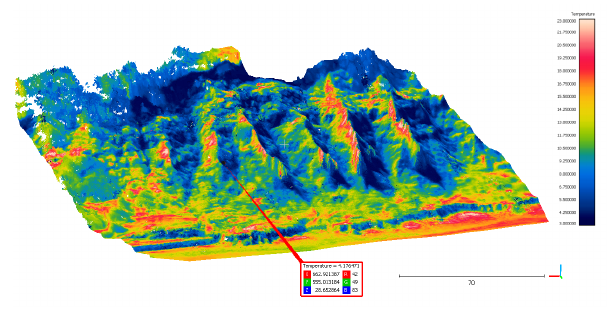
Figure 8. Enriched 3D model.